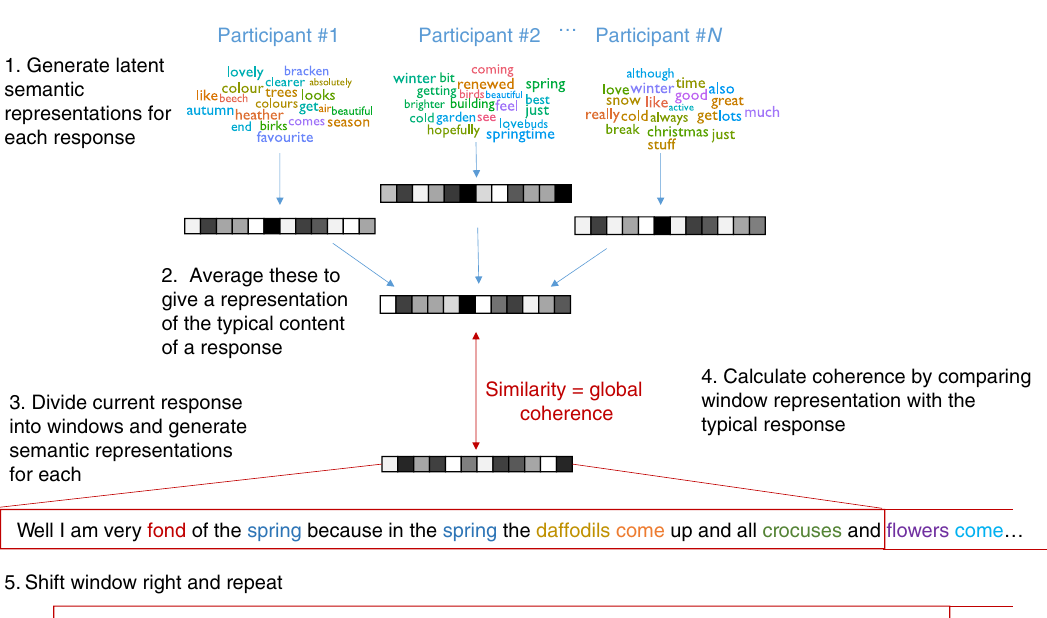
Fig. 7 Process for computing coherence in speech samples. 1. LSA was used to generate a vector coding the semantic content of each participant ’ s response to a given prompt. 2. These were averaged to give a representation of the semantics of a prototypical response. 3. The current response was divided into windows of 20 words and semantic representations computed for each window. 4. Global coherence was computed by calculating the similarity of the speech produced in the window to the prototypical response to the prompt. A high level of similarity indicated that the current response was closely related to the material typically associated with the topic. This coherence value was assigned to the fi nal word in the window. 5. The window was shifted one word to the right and the process